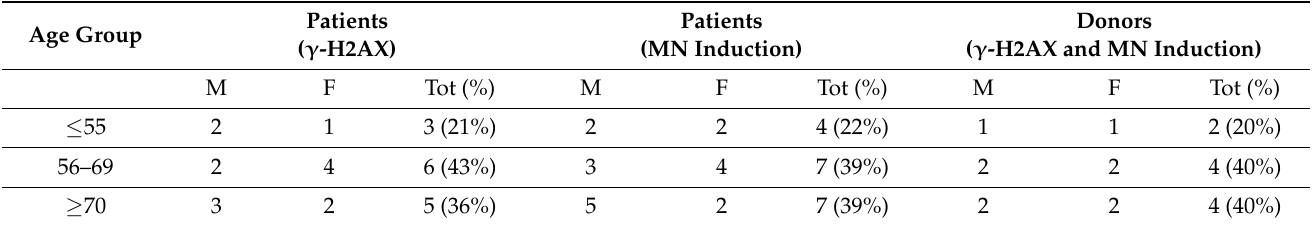
Table 5. Grouping of patients and healthy donors according to age and